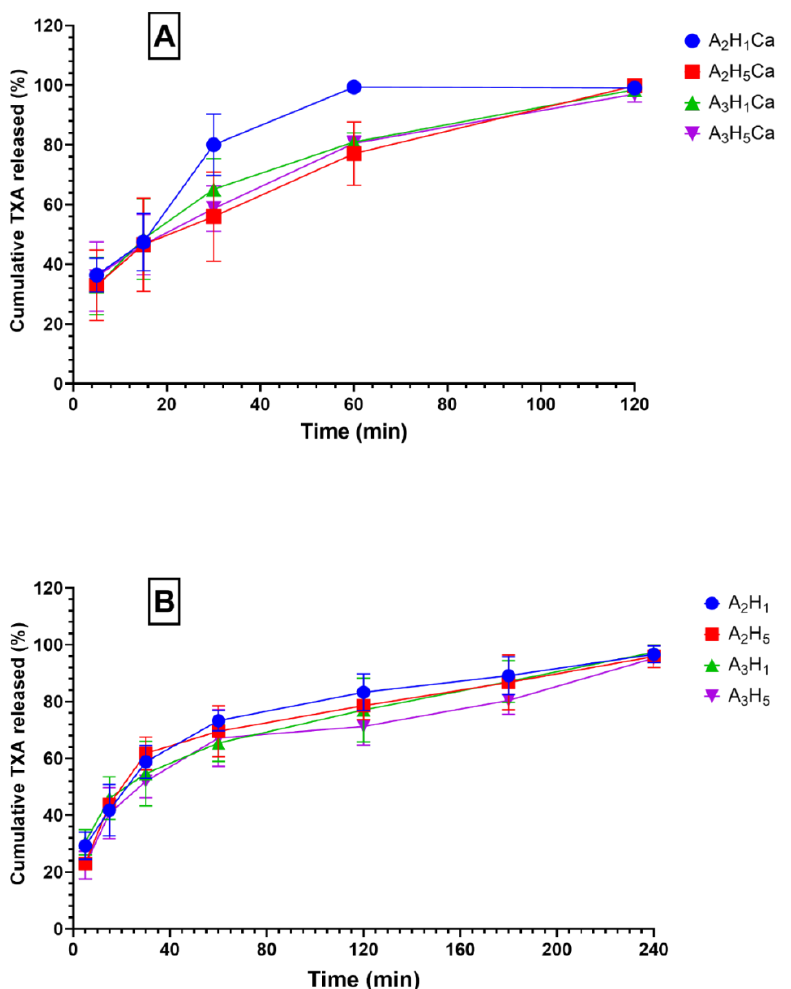
Figure 2. Cumulative release profile of tranexamic acid (TXA) in simulated body fluid; ( A ) monopha- sic release pattern of A 2 H 1 Ca, A 2 H 5 Ca, A 3 H 1 Ca, and A 3 H 5 Ca aerogels; ( B ) biphasic release pattern of A 2 H 1 , A 2 H 5 , A 3 H 1 , and A 3 H 5 aerogels. A biphasic release of TXA is seen for A 2 H 1 , A 2 H 5 , A 3 H 1 , and A 3 H 5 over 4 h. More than